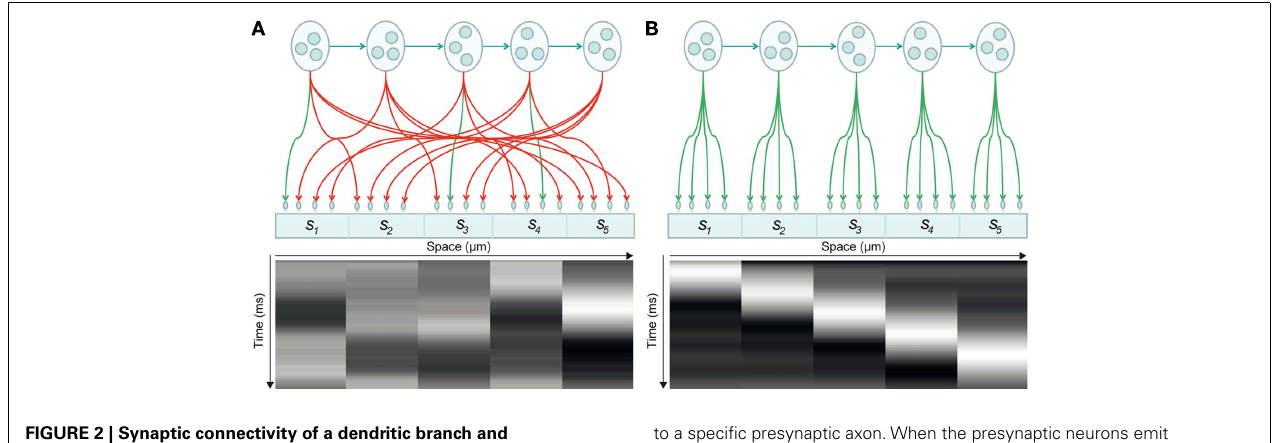
FIGURE 2 | Synaptic connectivity of a dendritic branch and induced intracellular dynamics. (A) Synaptic connectivity of a branch and its associated spatiotemporal voltage depolarization before synaptic reorganization. In this model, pools of presynaptic neurons fire at specific times, thereby establishing a hidden sequence of action potentials.The dendritic branch consists of a series of segments, where each segment contains a number of synapses (here: five segments with four synapses each). Each of the 20 synapses connects